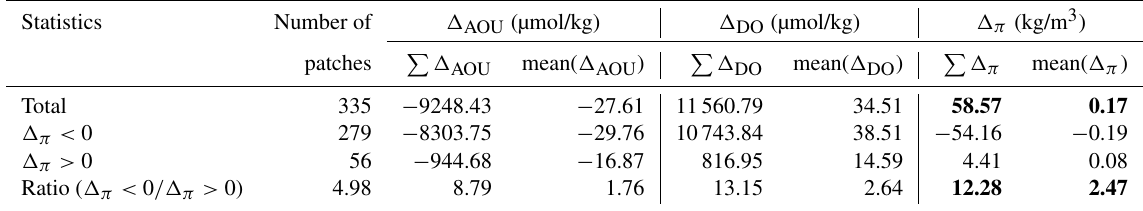
Table 2. Summary of the subduction patches associated with positive and negative π anomalies; bold numbers indicate statistics of the sum and mean based on absolute values of π